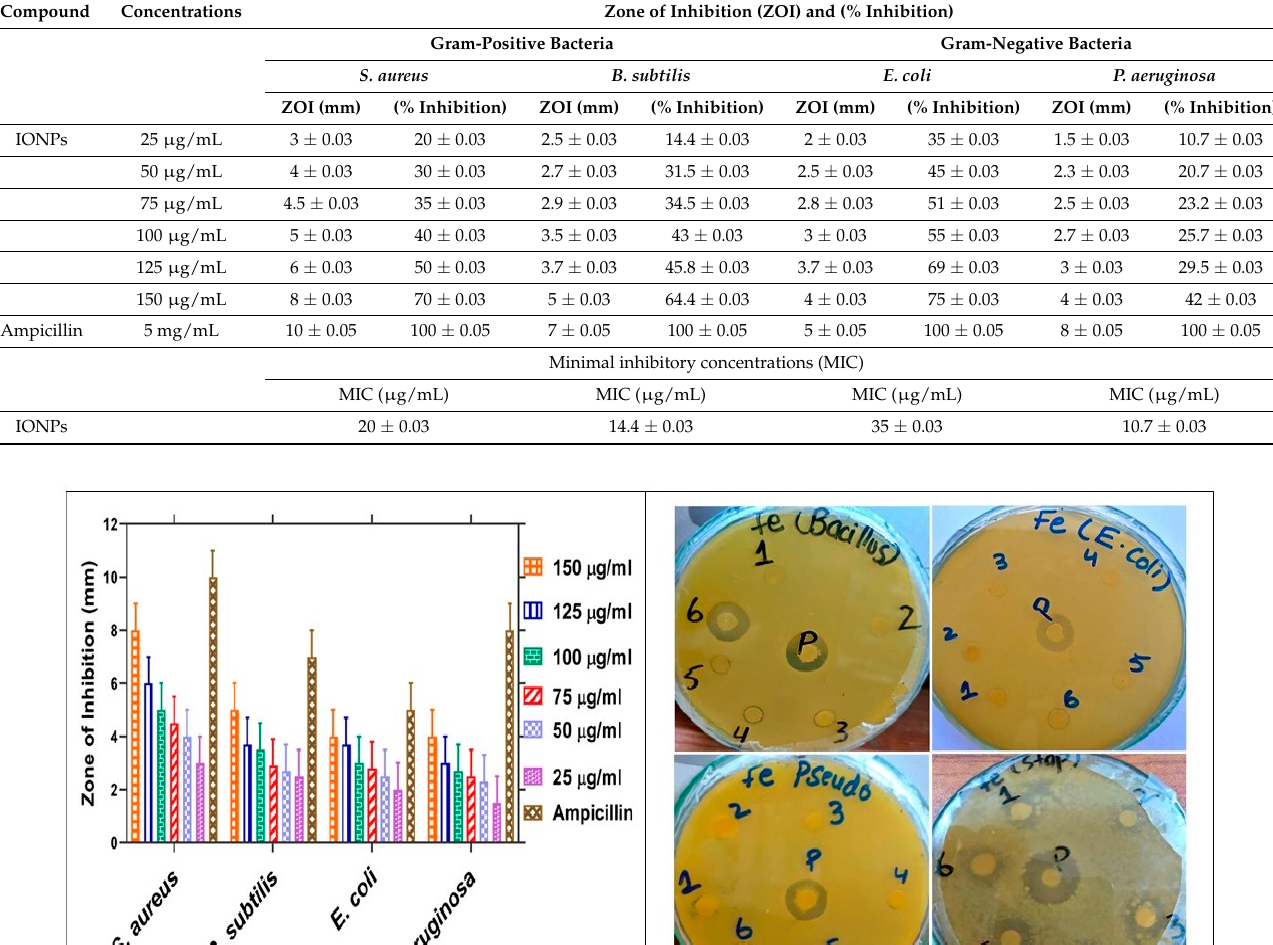
Table 1. Zone of inhibition (ZOI) and Minimal inhibitory concentrations (MIC) calculations of different bacterial strains.